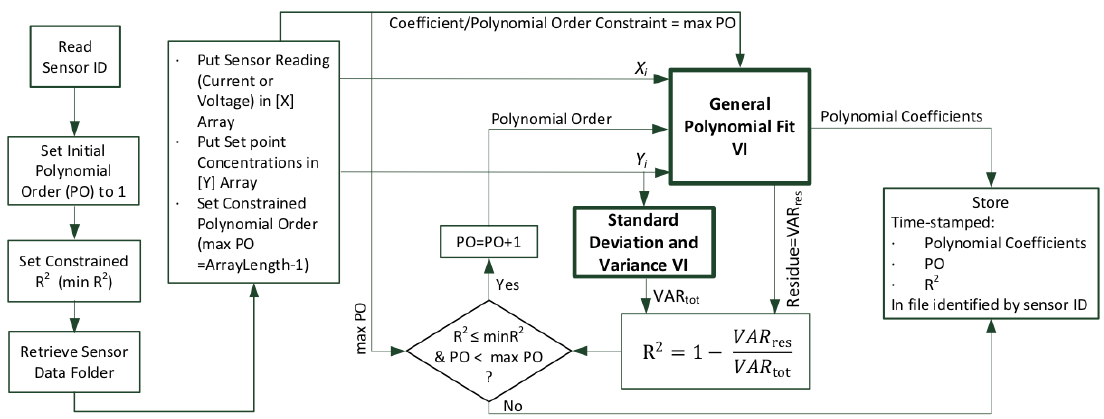
Figure 11. Implementation of the curve fitting for a single sensor using a dedicated LabVIEW VI.